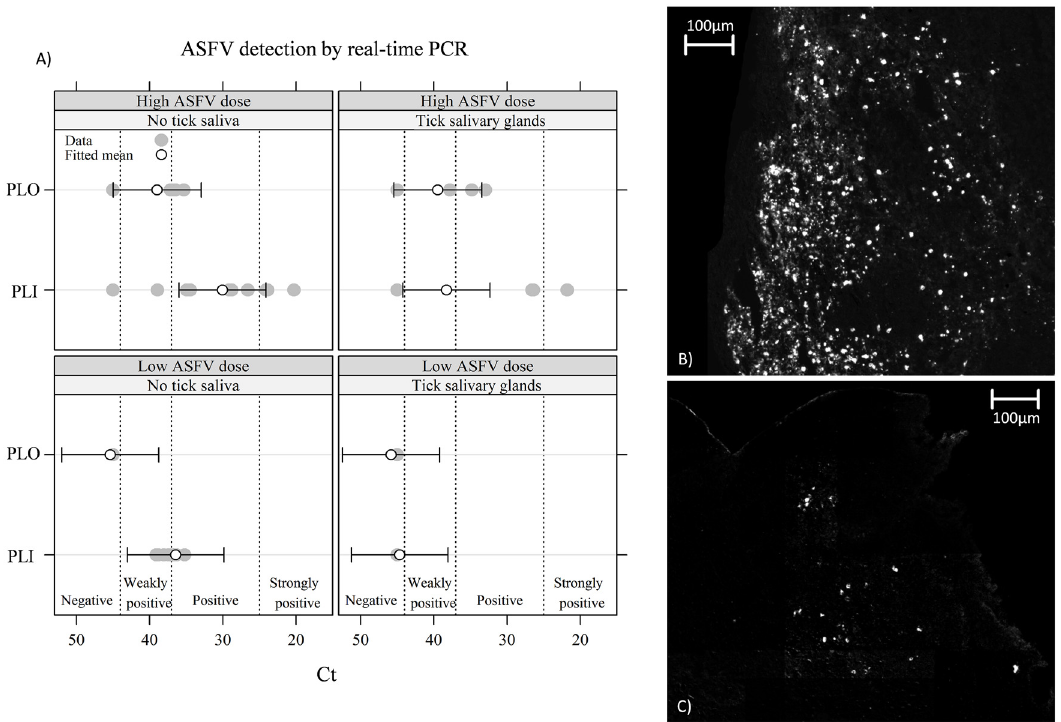
Fig 2. Viral detection in parotid lymph nodes at 48 h pi. (A) Quantification of ASFV DNA using real-time PCR. Real-time PCR results were categorized as negative ( C t > 45), weakly positive (44 (cid:3) C t > 37), positive (36 (cid:3) C t > 26) and strongly positive ( C t < 25). The mean was fitted with a linear mixed-effect model. (B) Virus labelling at 48 h pi in parotid lymph nodes (inoculation side) for pigs receiving a high ASFV dose alone. (C) Virus labelling at 48 h pi in parotid lymph nodes (inoculation side) for pigs receiving a high ASFV dose and tick salivary gland extract. Virus protein VP72 was labelled by immunofluorescence. PLI: parotid lymph node on inoculation side; PLO: parotid lymph node on opposite side.